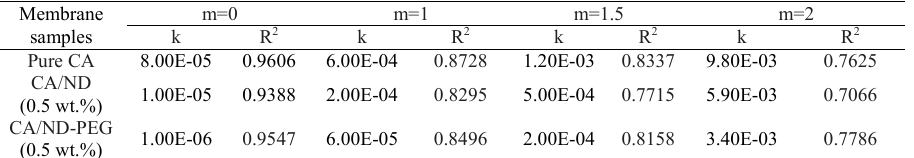
Table 4. Obtained k and correlation coefficient R 2 values for Hermia fouling models.